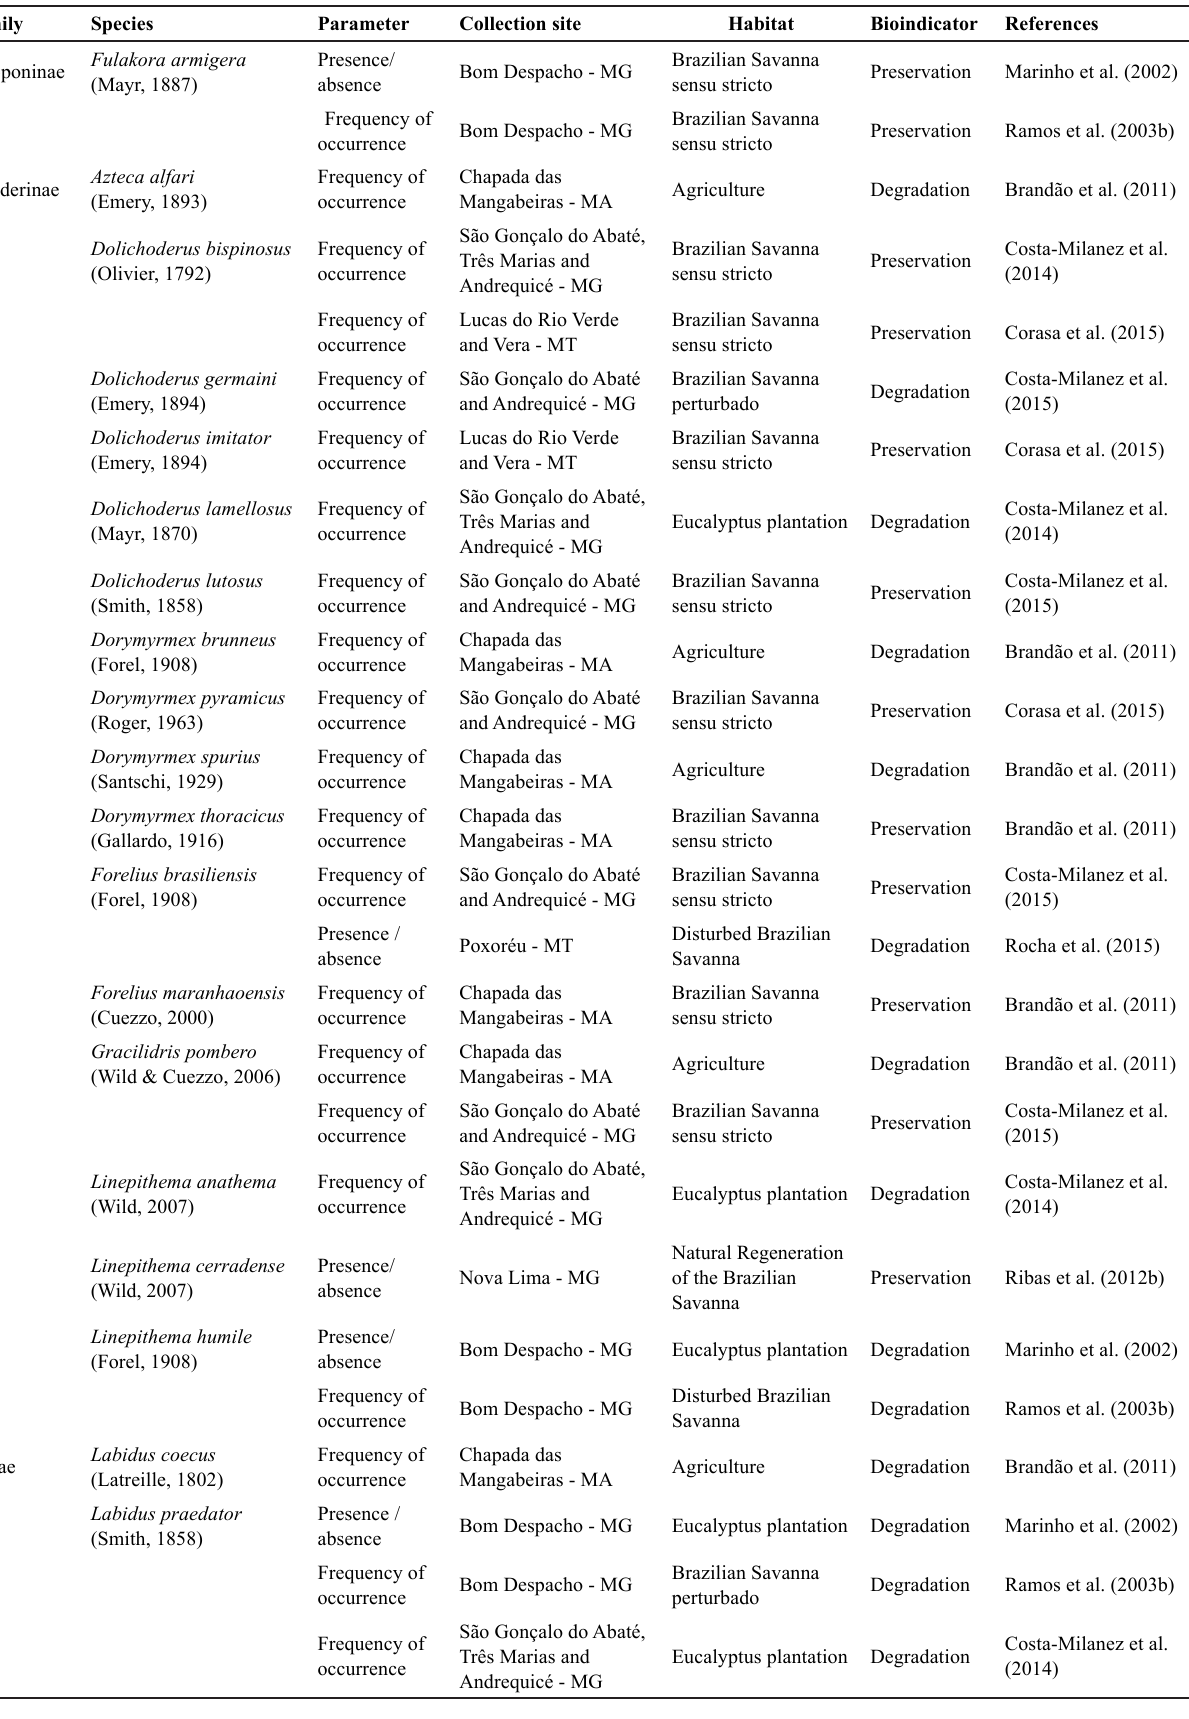
Table 3. Species of ants defined as bioindicators for preservation or degradation in the reference studys, indicating the parameter used to relate to the habitat type, and the reference of the papers